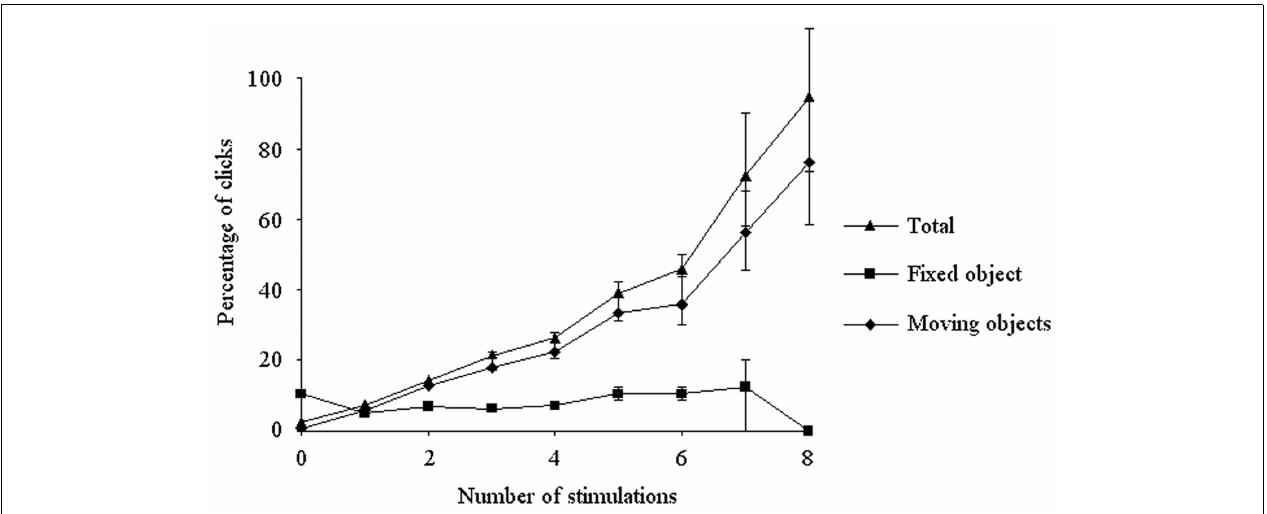
mobile lure); Squares: stimulations due to encounters with the fixed object; Triangles: stimulations due to encounters with a moving object (avatar or mobile lure). Error bars represent the standard errors of the